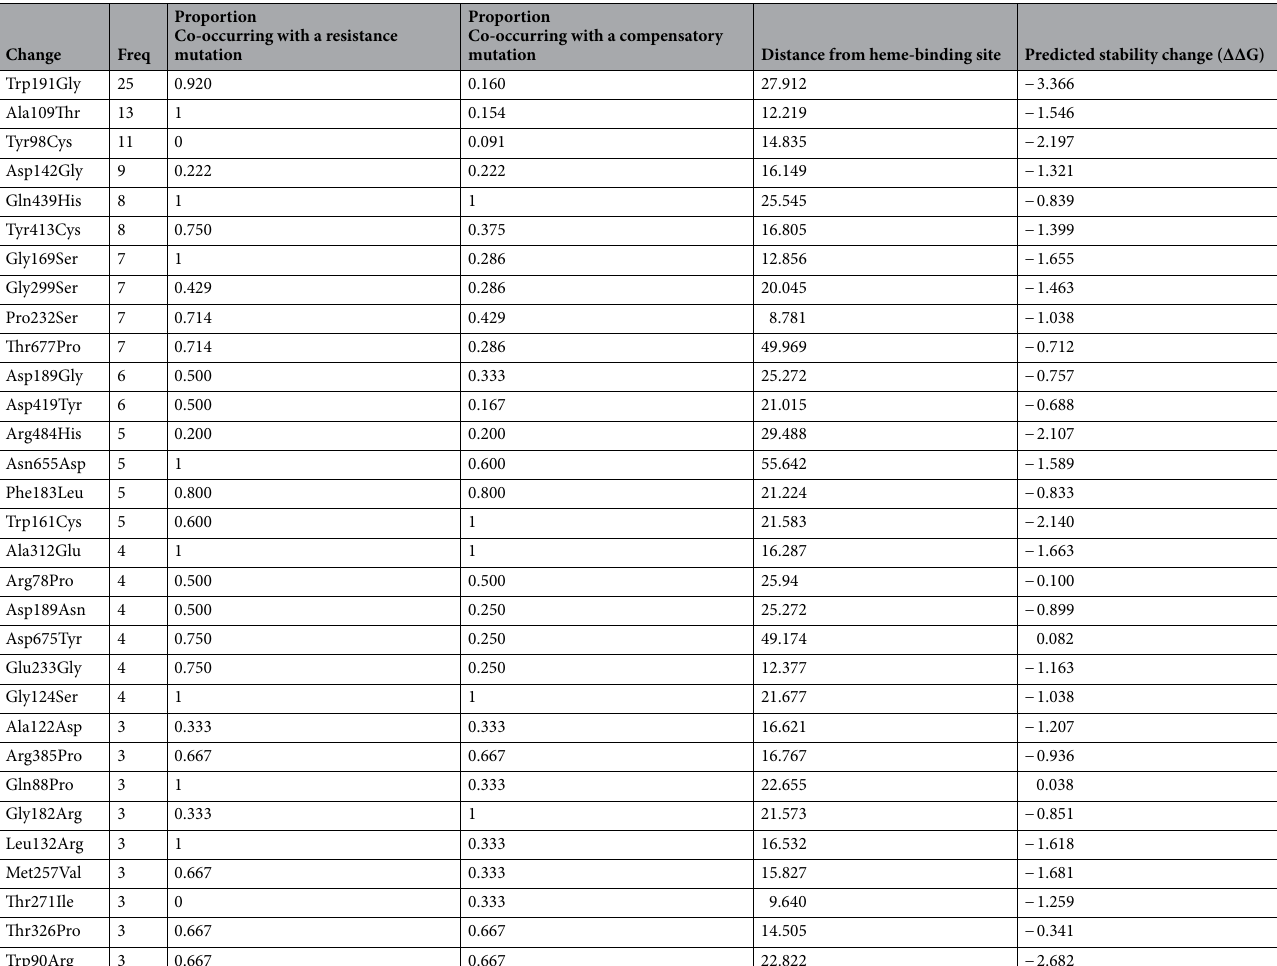
Table 2. List of 31 high-quality potential resistance mutations for isoniazid in the katG gene (171